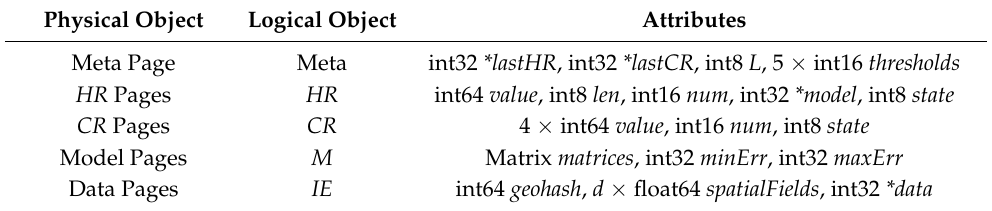
Table 3. SLBRIN objects.